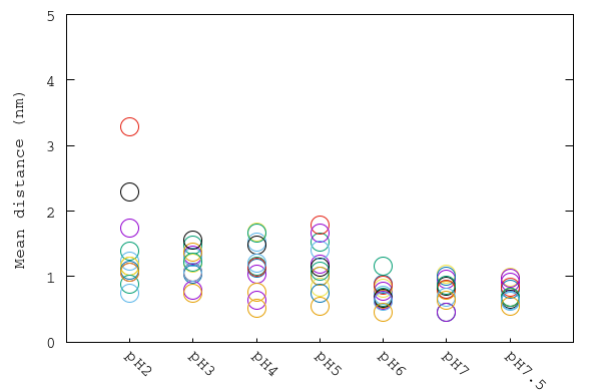
Figure 7. Average root-mean-square deviation (RMSD) values of backbone atoms of each flap at different pH simulations. Each flap is aligned with respect to the backbone atoms of its corresponding dimer. Each flap is displayed with a different color.